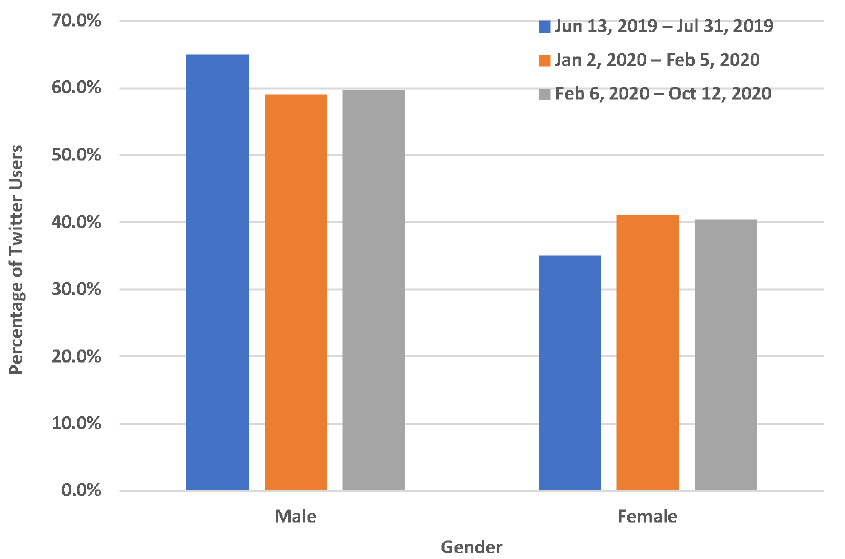
Figure 2. Gender characteristics of Twitter users who mentioned quitting vaping. 13 June 2019–31